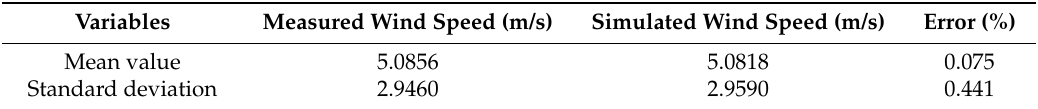
Table 3. Statistical characteristics of wind speed samples.